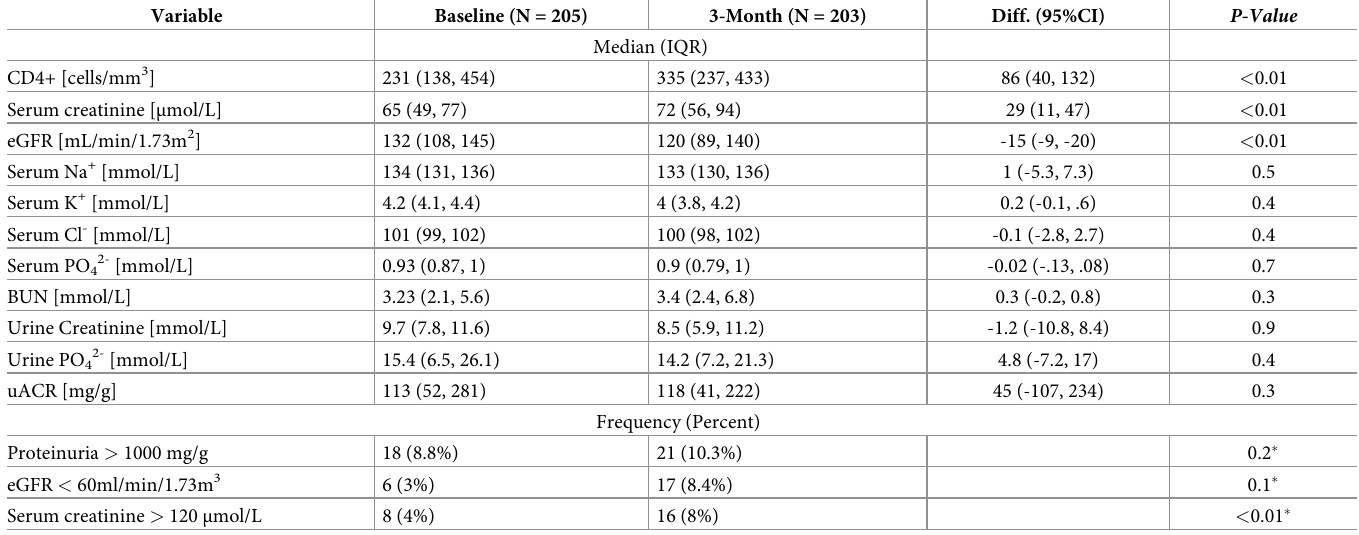
Table 2. Change in clinical and laboratory characteristics following 3-months of TDF-based therapy.